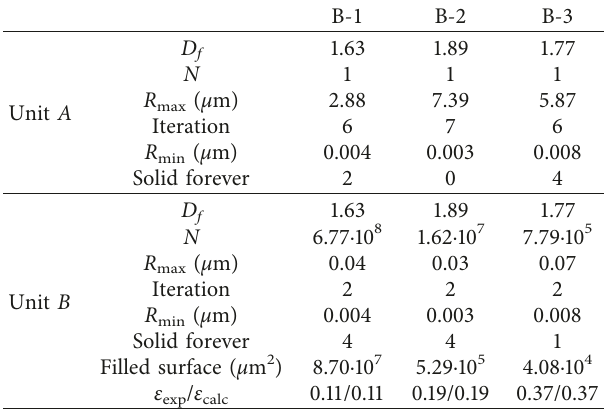
Table 2: IFU input data to models B-1, B-2, and B-3. The fractal dimension ( D f ), the maximum ( R max ) and minimum rays ( R min ), the number of iterations, the number of solid forever squares for each base unit (the Sierpinski carpet), the number of B base units ( n B ), the filled surface (FS) used to build the IFU, and comparison between experimental ( ε exp ) and predicted pore volume fractions ( ε IFU ). B-1 B-2 B-3